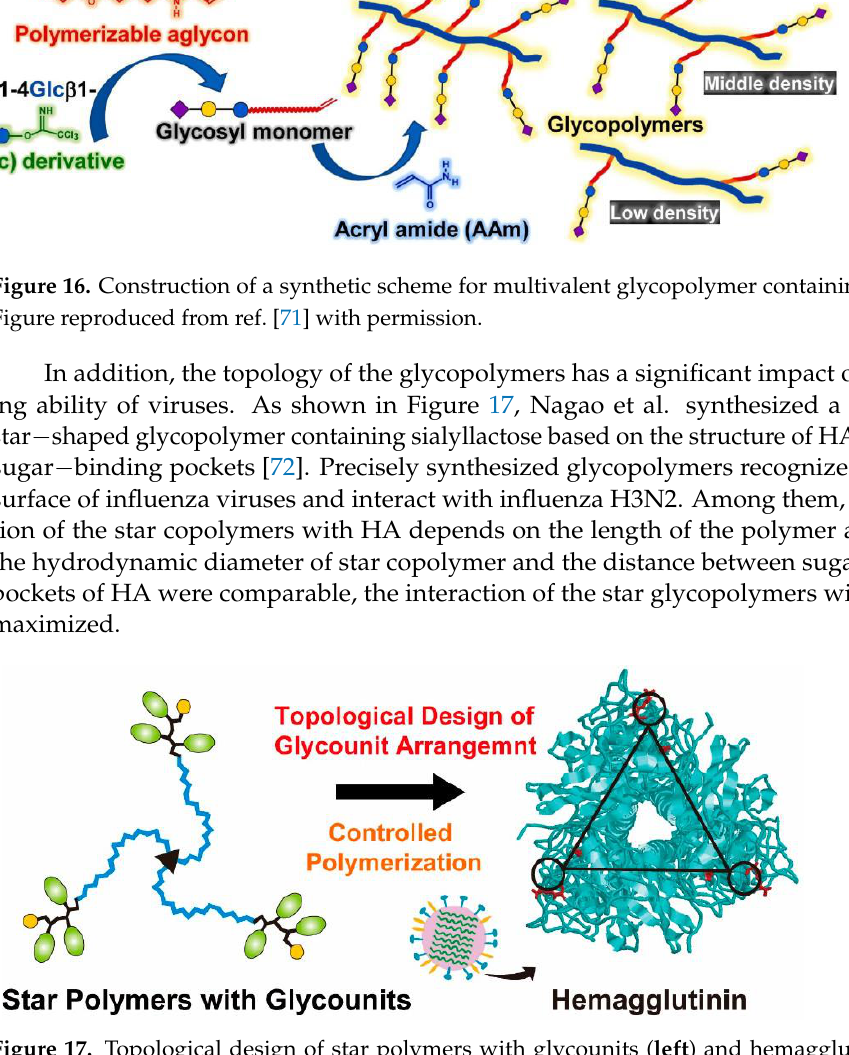
Figure 17. Topological design of star polymers with glycounits ( left ) and hemagglutinin ( right ). Figure reproduced from ref. [72] with permission.